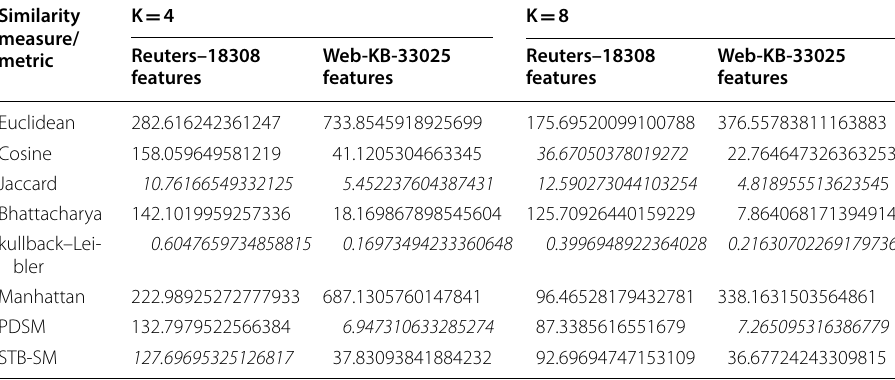
Italic values indicate the highest values that top measures achieved for corresponding evaluation